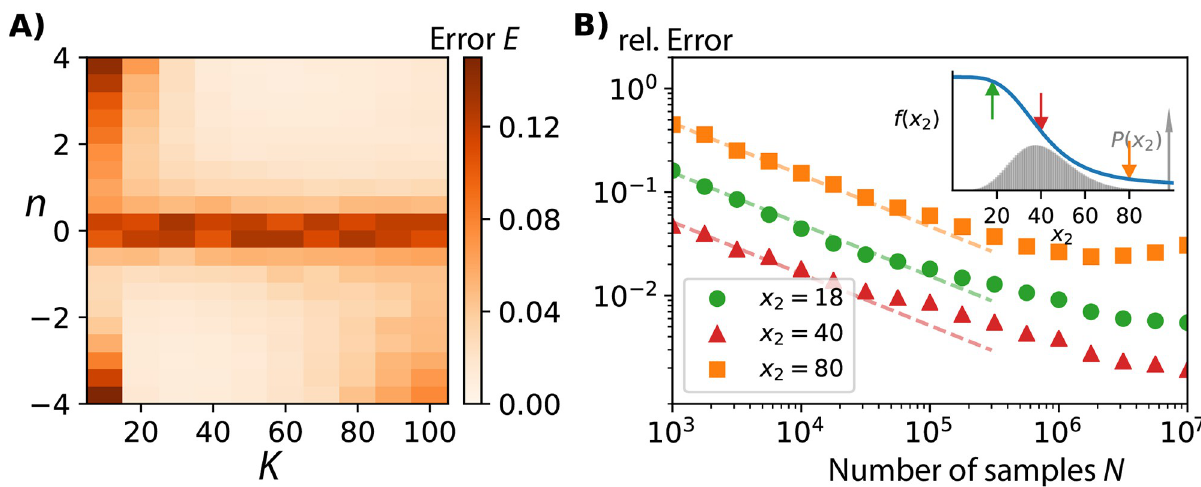
Fig 5. Non-linear degradation does not affect the inference. A) For simulated systems with non-linear degradation of X 3 -molecules as defined in Eq (7), the inference quality is satisfactory when using empirically determined joint probability distributions P ( x 2 , x 3 ) from N = 100, 000 samples. Plotted are the inference error E for different production rates f ð x Þ ¼ l x n = ð x n þ K n Þ . Poor inference corresponds to parameter regimes in which the upstream 2 2 2 variable X 2 has only a negligible effect on the downstream variable X 3 , i.e., when K or n are small. Data are for the same noise enhancing three- component system as in Fig 3 with the only difference that the degradation of X 3 is now non-linear. B) For a given state, the relative error of the inferred ffiffiffiffi p reaction rate f ( x 2 ) initially decreases / 1 = (dashed lines) as the number of sampling points N increases. However, for large N , the relative error N levels off, with higher probability states reaching a lower plateau than those only visited rarely. The inset depicts the true function and the specific states considered here, as well as the resulting probability distribution of x 2